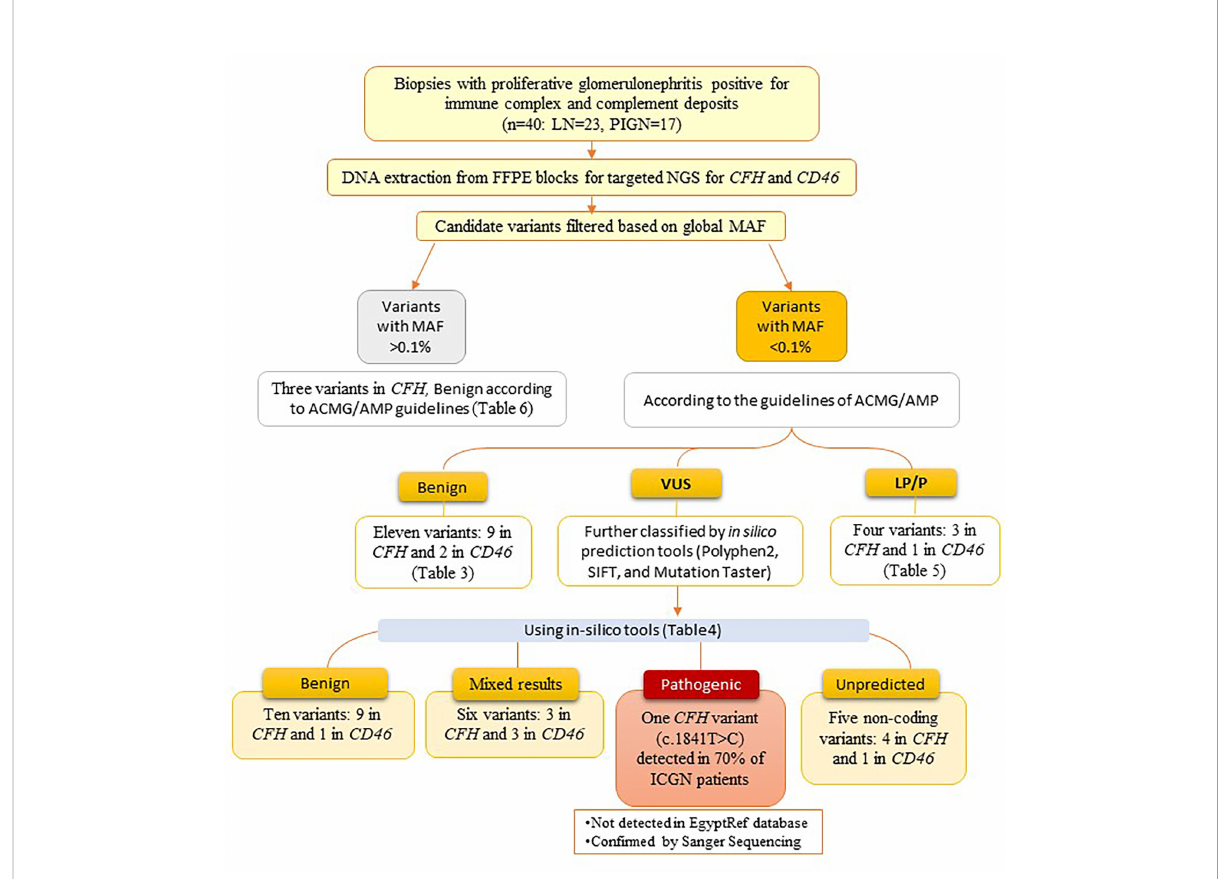
FIGURE 3 Flowchart showing a summary of the variants detected in CFH and MCP genes among the studied